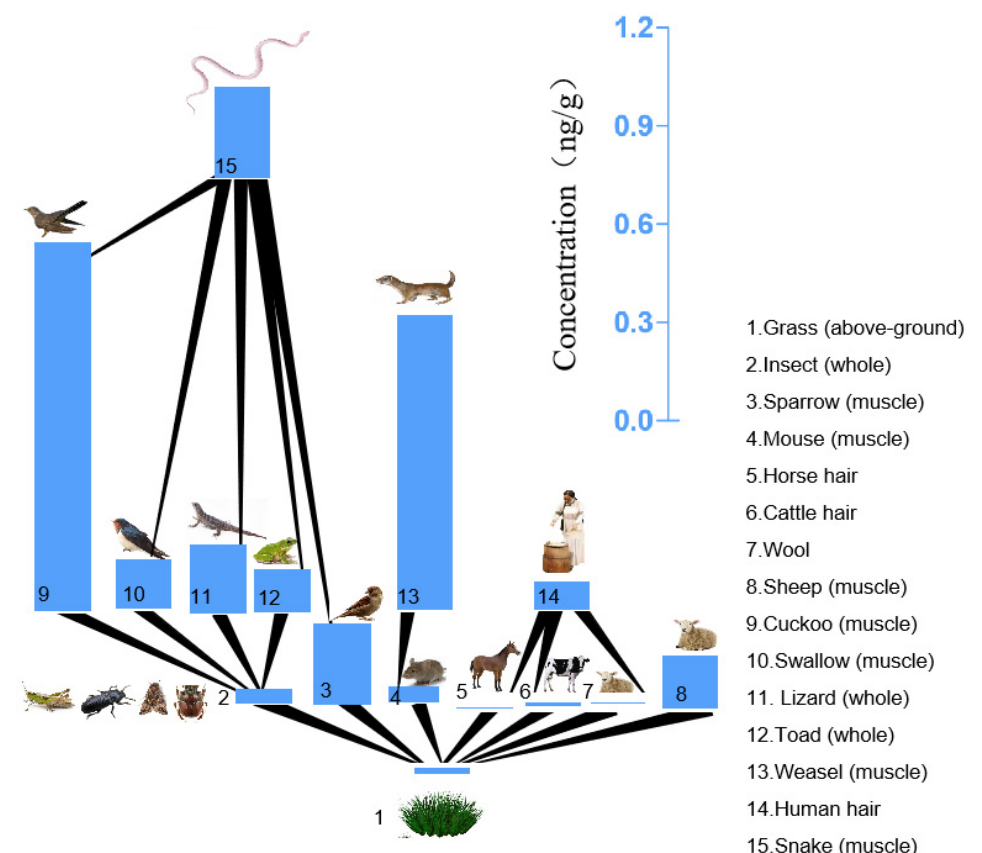
Figure 2. Novel brominated flame retardant concentrations found in the samples from the Xilingol grassland, China. Notes: The concentrations in (1) grass, (5) horse hair, (6) cattle hair, (7) wool, and (14) human hair are in ng/g dry weight and the concentrations in (2) insects, (3) sparrow, (4) mouse, (8) sheep, (9) cuckoo, (10) swallow, (11) lizard, (12) toad, (13) weasel, and (15) snake are in ng/g lipid weight.